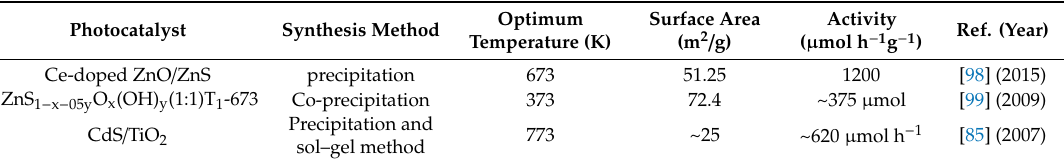
Table 9. E ff ects of calcination treatment on photocatalytic